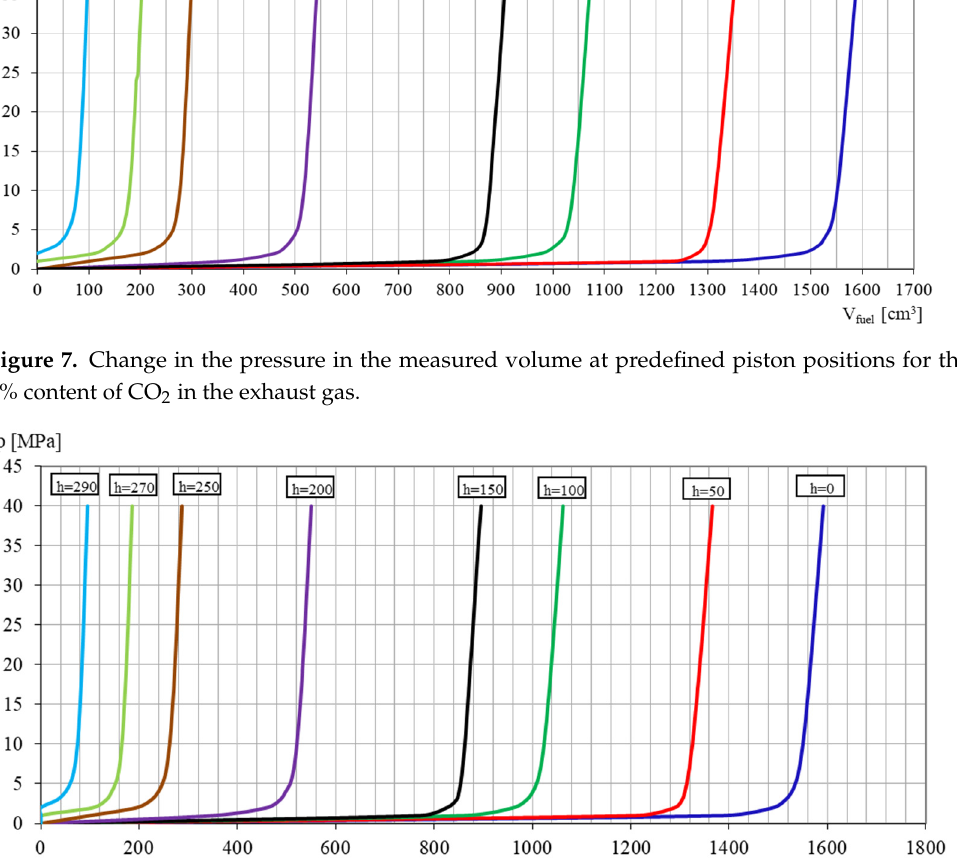
Figure 9. Change in the pressure in the measured volume at predefined piston positions for the 10% content of CO 2 in the exhaust gas. The recorded allocation of ∆𝑉 (cid:3002)(cid:3003) and ∆𝑝 (cid:3002)(cid:3003) is the result of the influence of the com- pressibility of the solution and the deformation of the entire equipment. With such high pressures and the relatively great size of the high-pressure system, the problem of defor- mation can be neglected. When estimating the rigidity of the components of the said sys- tem, the authors concluded that the rigidity of the frame was at least 10 times greater than the rigidity of the outstanding components, which is why the deformation of the frame was omitted. However, the radial deformation of the cylinder along with the longitudinal deformation of the piston/piston pusher position adjustment screw were taken into ac- count. The results of the measurements of the bulk modulus of the solution of diesel fuel and exhaust gas, allowing for the deformation of the measurement system, are shown in Figure 10.